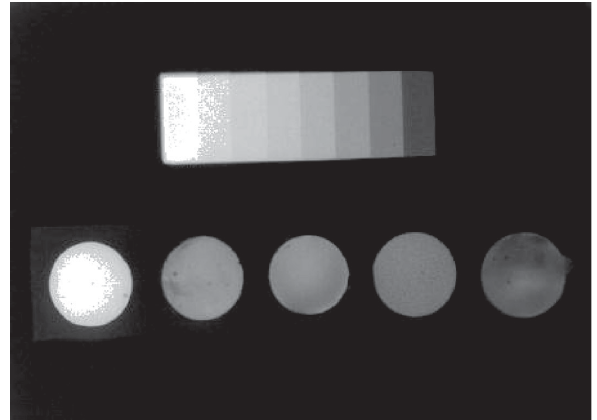
FIGURE 2- Radiograph showing the radiopacity of AH Plus sealer and its equivalence to the aluminum step wedge